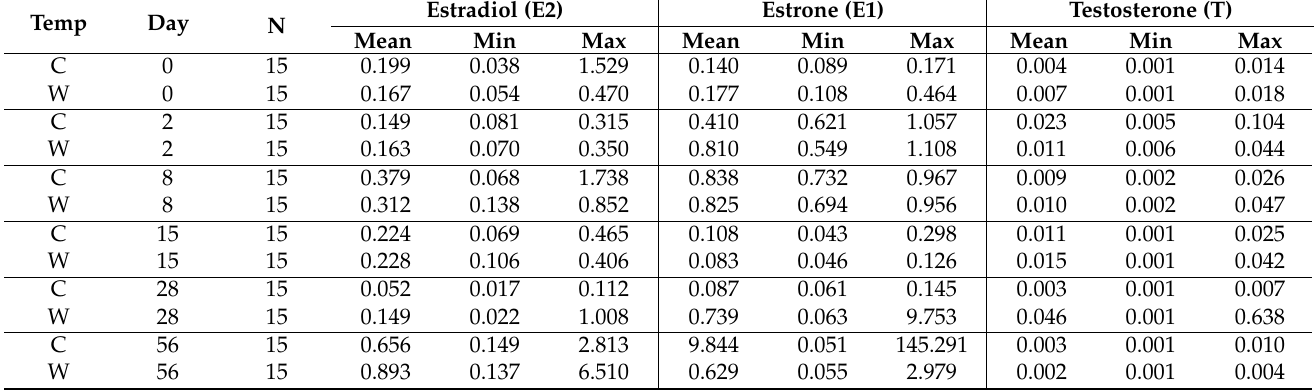
Table 1. Average and range (in pg/mg) of raw values (including outliers) of the sex hormones quanti- fied in Chrysemys picta reproductive females per temperature and sampling day. Temp = temperature treatment. N = sample size. Min = minimum value. Max = Maximum